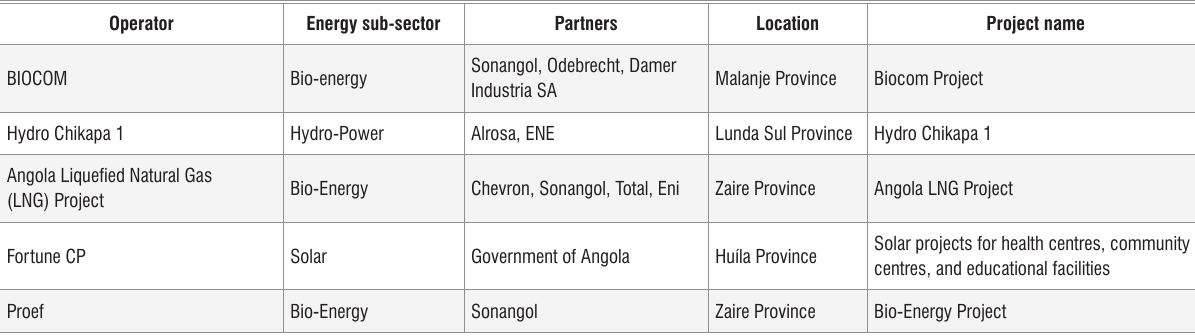
Main inward foreign direct investment into non-oil and gas energy subsectors Operator